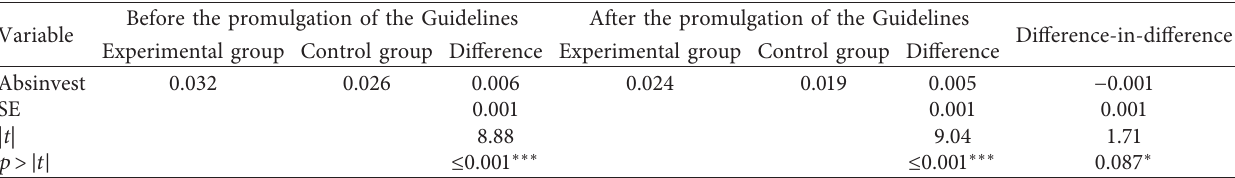
Table 7: Test results of